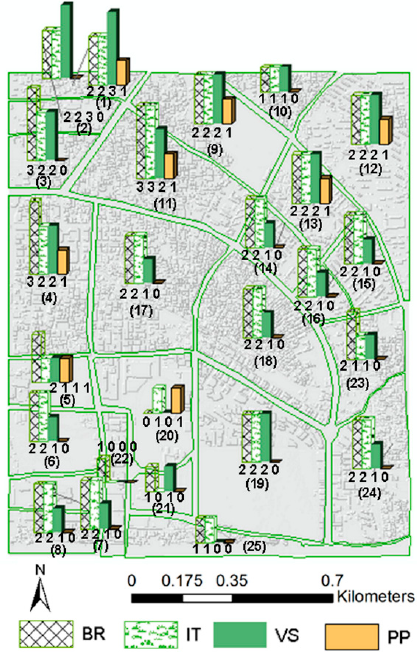
Figure 3. Green infrastructure for the Segunbagicha catchment in Dhaka showing the maximum possible number of practices in each subcatchment: bio-retention cells (BR); infiltration trench (IT); vegetative swale (VS); and porous pavement (PP).